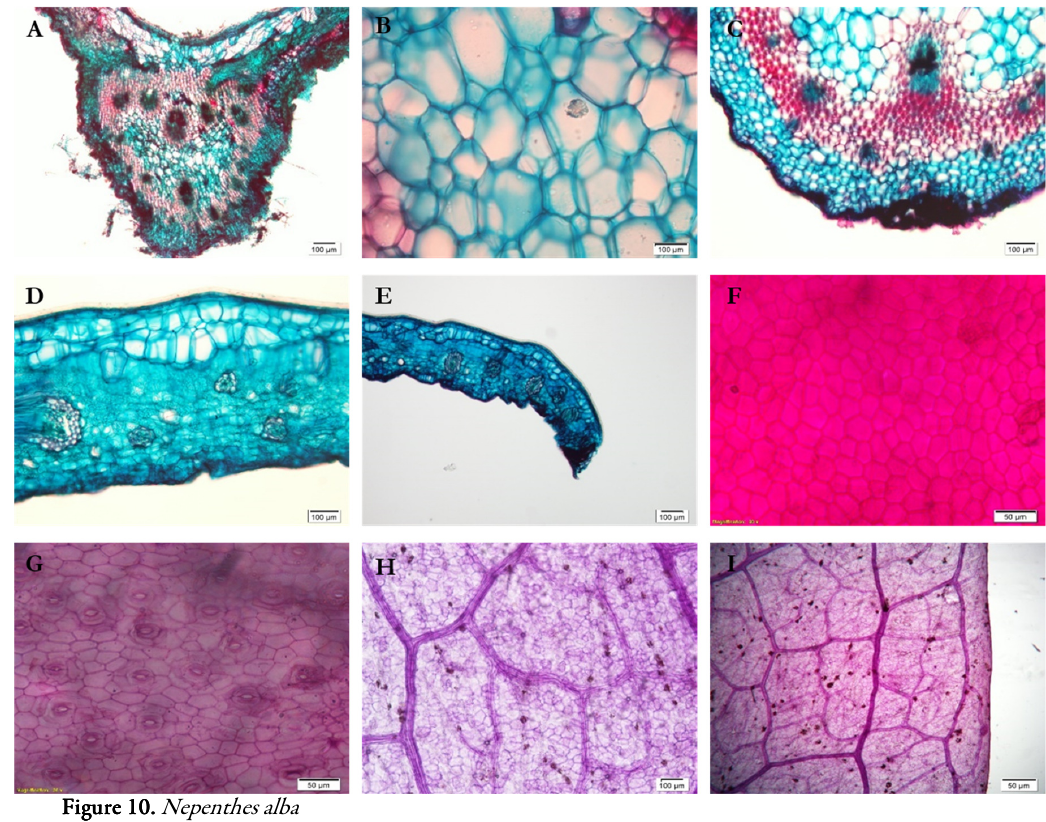
Figure 10. Nepenthes alba (A) Midrib TS. (B) Observation of solitary crystals, (C) Vascular bundle, (D) Lamina TS (E) Margin TS, (F) Adaxial epidermis, (G) Abaxial epidermis with stomata observation, (H) Lamina venation. (I) Margin venation. Bars F, G, I: 50µm; A, B, C, D, E, H: